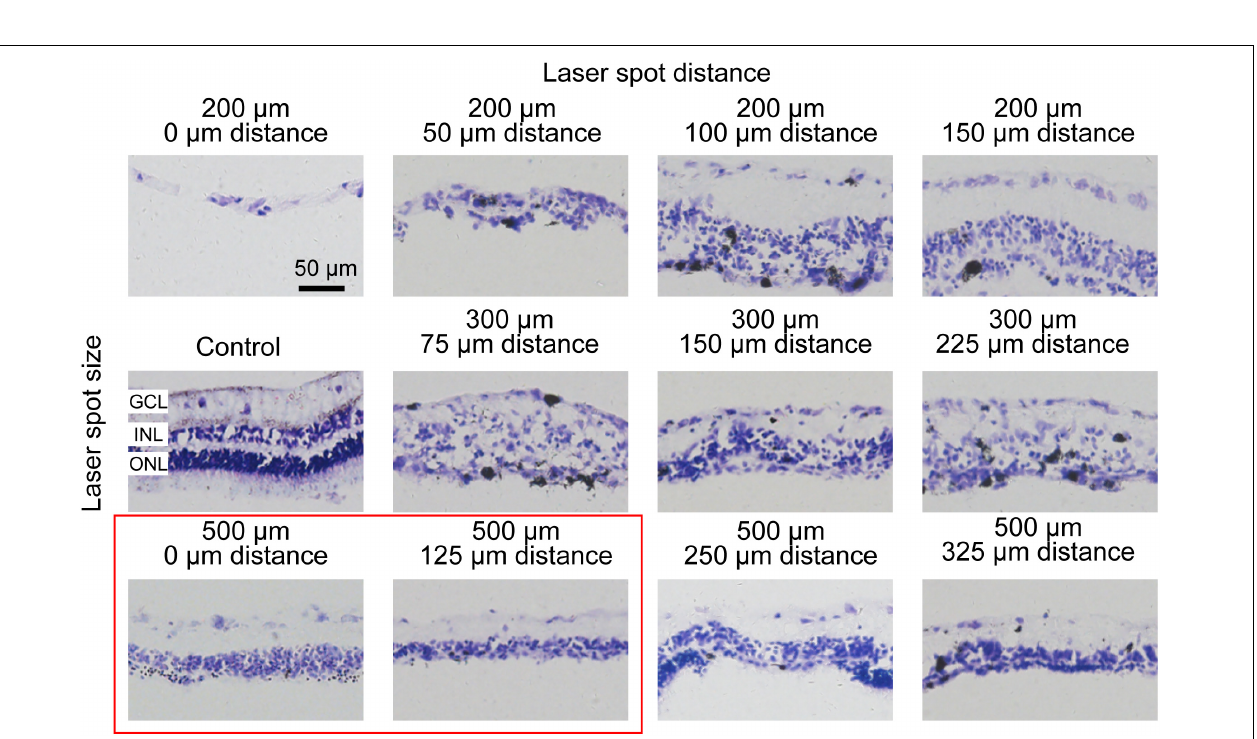
FIGURE 3 | Histomorphology of rabbit retinas 7 days after photocoagulation with 100 mW laser power and 50 ms pulse duration. Histologic images for different laser spot size and distance. The control picture is in the first column and second row. Except for the control picture, each row corresponds to a constant laser spot size, and each column to different laser spot distance. The better conditions are circled by the red box. GCL, ganglion cell layer; INL, inner nuclear layer; ONL, outer nuclear layer. Scale bar = 50 µ